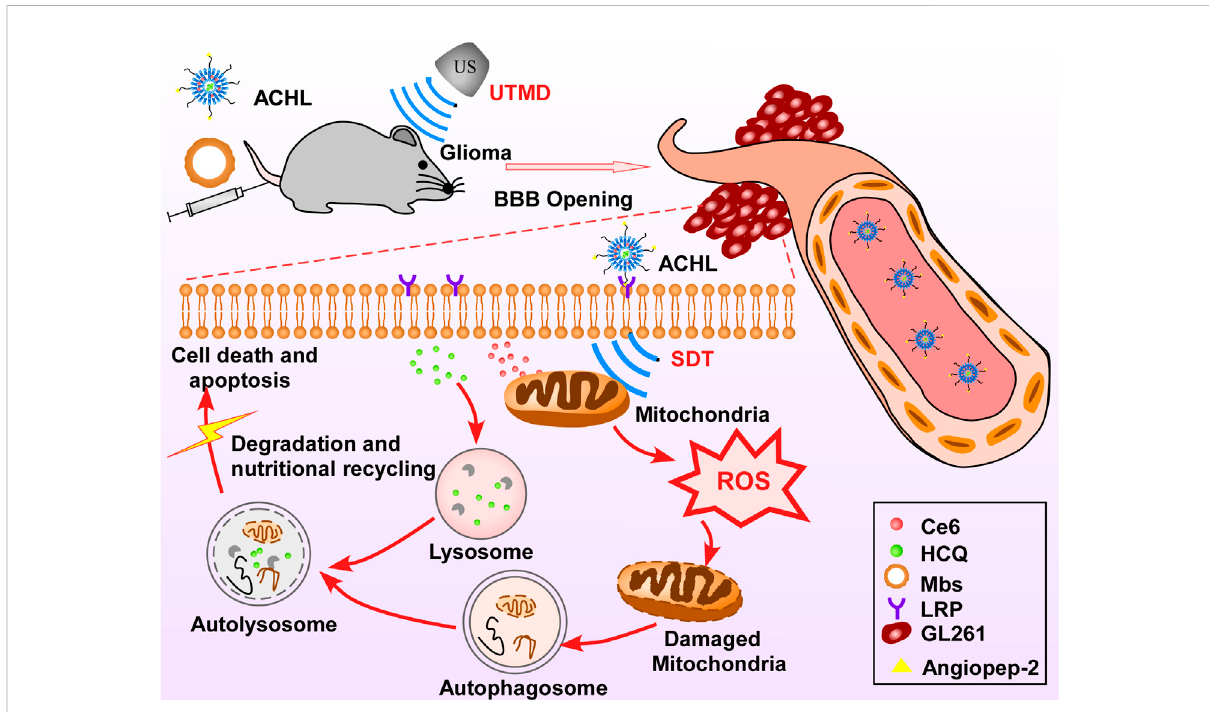
FIGURE 4 Schematic of “ all-in-one ” nanosensitizer platform. An “ all-in-one ” nanosensitizer platform by incorporating Ce6 and HCQ into angiopep-2 peptide-modi fi ed liposomes (designated ACHL) for orthotopic glioma theranostics was designed. An initial ultrasonic pulse (US1) destroyed the microbubbles and promoted the ACHL into the reversibly opened BBB, while a second ultrasonic stimulus (US2) generated the SDT effects. SDT- mediated mitophagy and its inhibition by HCQ were evaluated, along with the anti-glioma effects. The MAPK/p38 signaling pathway contributed to the progression of mitophagy induced by